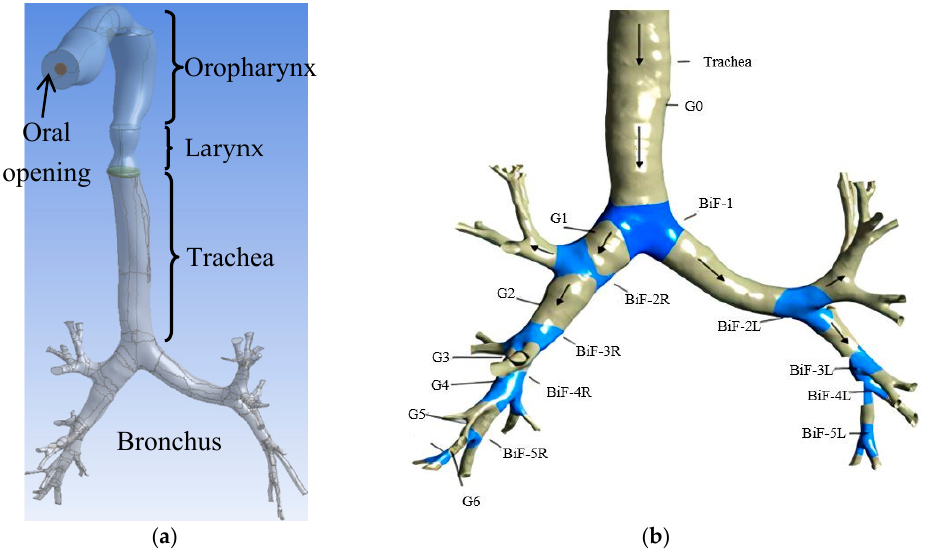
Figure 1. HRT model from the oral cavity to sixth-generation bronchi with bronchial bifurcations and generations. ( a ) HRT Model ( b ) Bronchial bifurcations (BiF) and Generations (G)